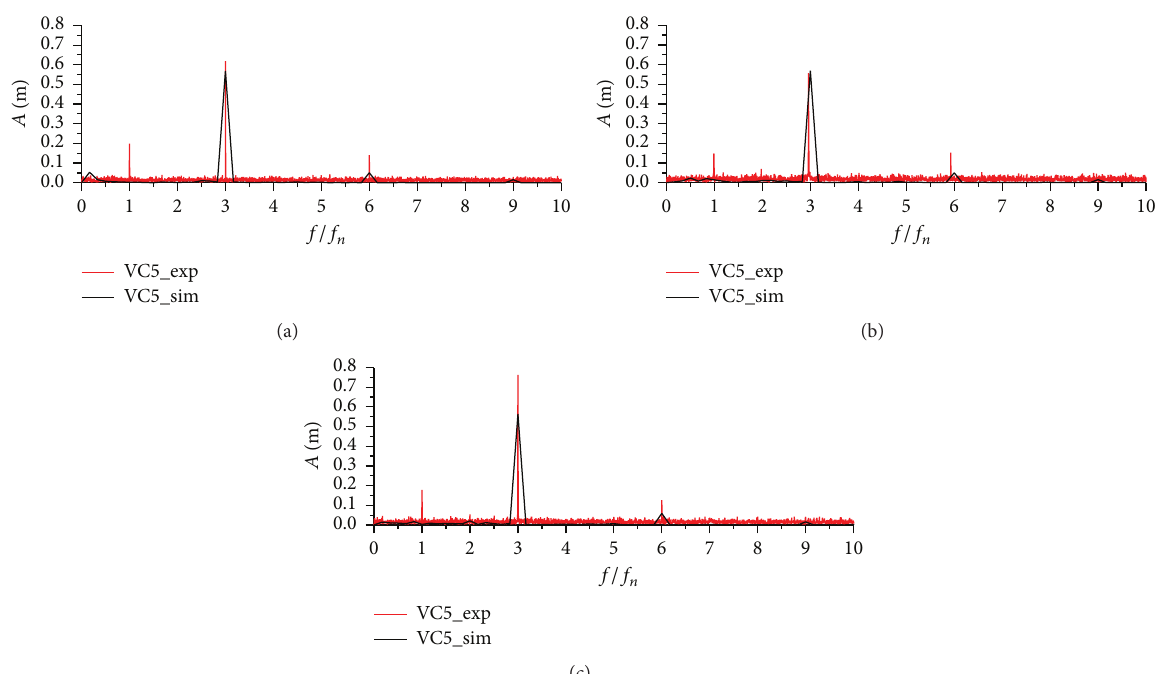
Figure 5: Comparison of the experimental and numerical frequency spectrum in three models: (a) M1, (b) M2, and (c) M3. 𝑓 𝑛 denotes rotating frequency.